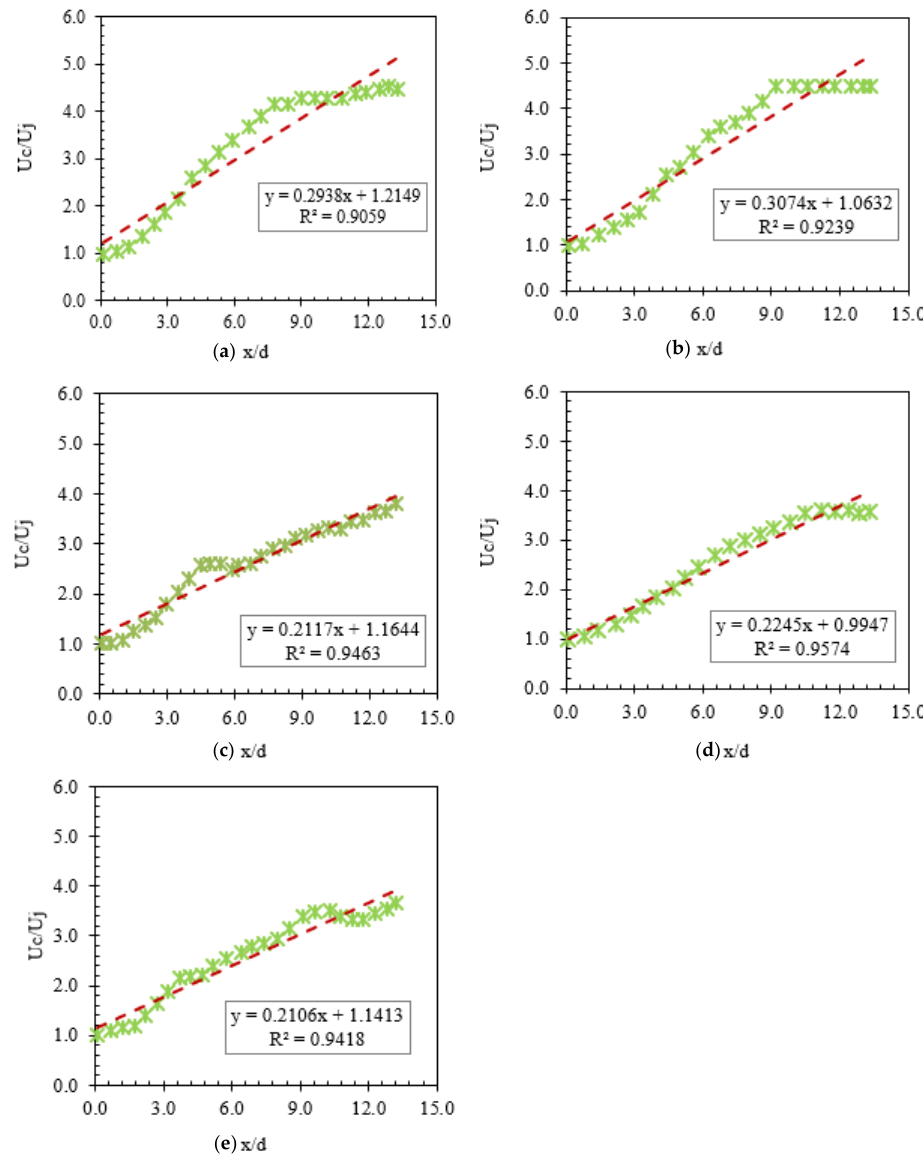
Figure 4. Decay of centreline velocity for nozzle velocity at ( a ) 0.18 m/s, ( b ) 0.32 m/s, ( c ) 0.45 m/s, ( d ) 0.62 m/s, and ( e ) 1.16 m/s. Radial velocities at three locations were extracted from the velocity field estimated by the wavelet-based technique. The normalization of these radial velocities with its max- imum usually results in Gaussian profiles. Figure 5 shows the normalized radial velocity at three locations selected at the fully developed region, i.e., x / d > 6 including x / d = 15, 20, and 25. The normalization of the velocity distribution at different locations by the